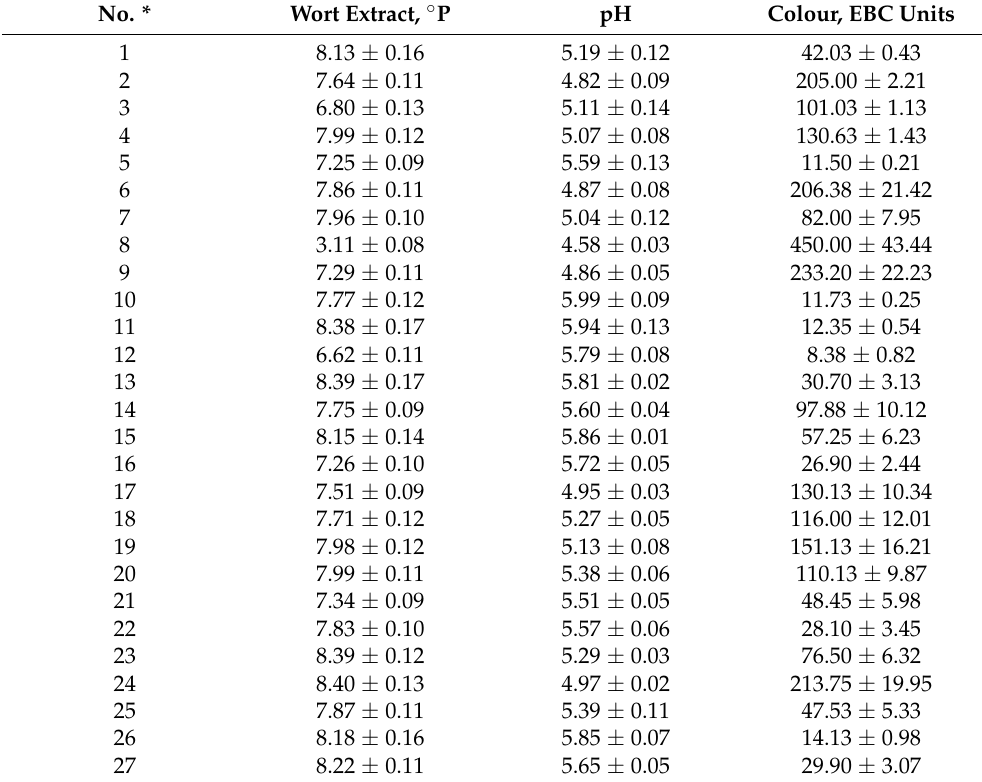
Table 2. Main brewing characteristics of wort produced from malt